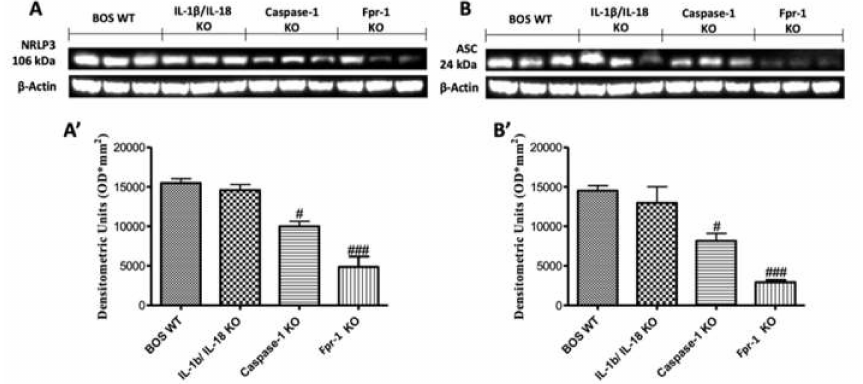
Figure 2. E ff ects of the absence of IL-1 β / IL-18, Casp-1, and Fpr-1 on the NRLP3 inflammasome pathway. Western blots and, respectively, the densitometric analysis of NRLP3 ( A , A’ ) and ASC ( B , B’ ). For Western blot analyses, n = 5 animals from each group were employed. A p -value less than 0.05 was considered significant. # p < 0.05 versus the WT group, ### p < 0.001 versus the WT group.